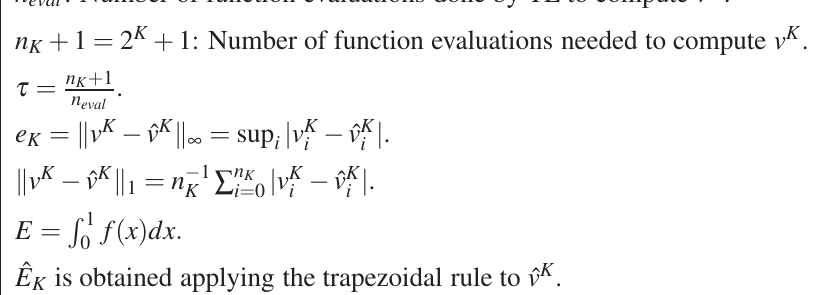
Table 1 Parameters for the numerical experiments.